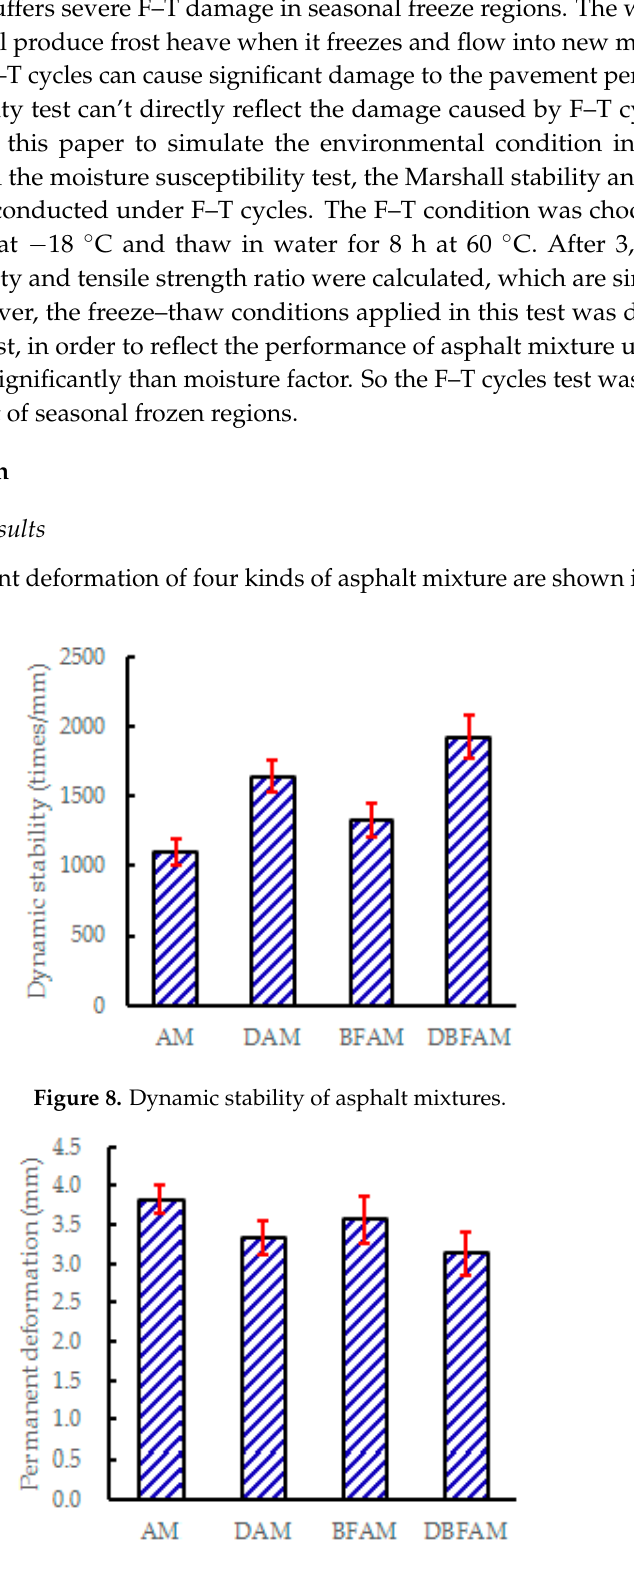
Figure 9. Permanent deformation of asphalt mixtures .